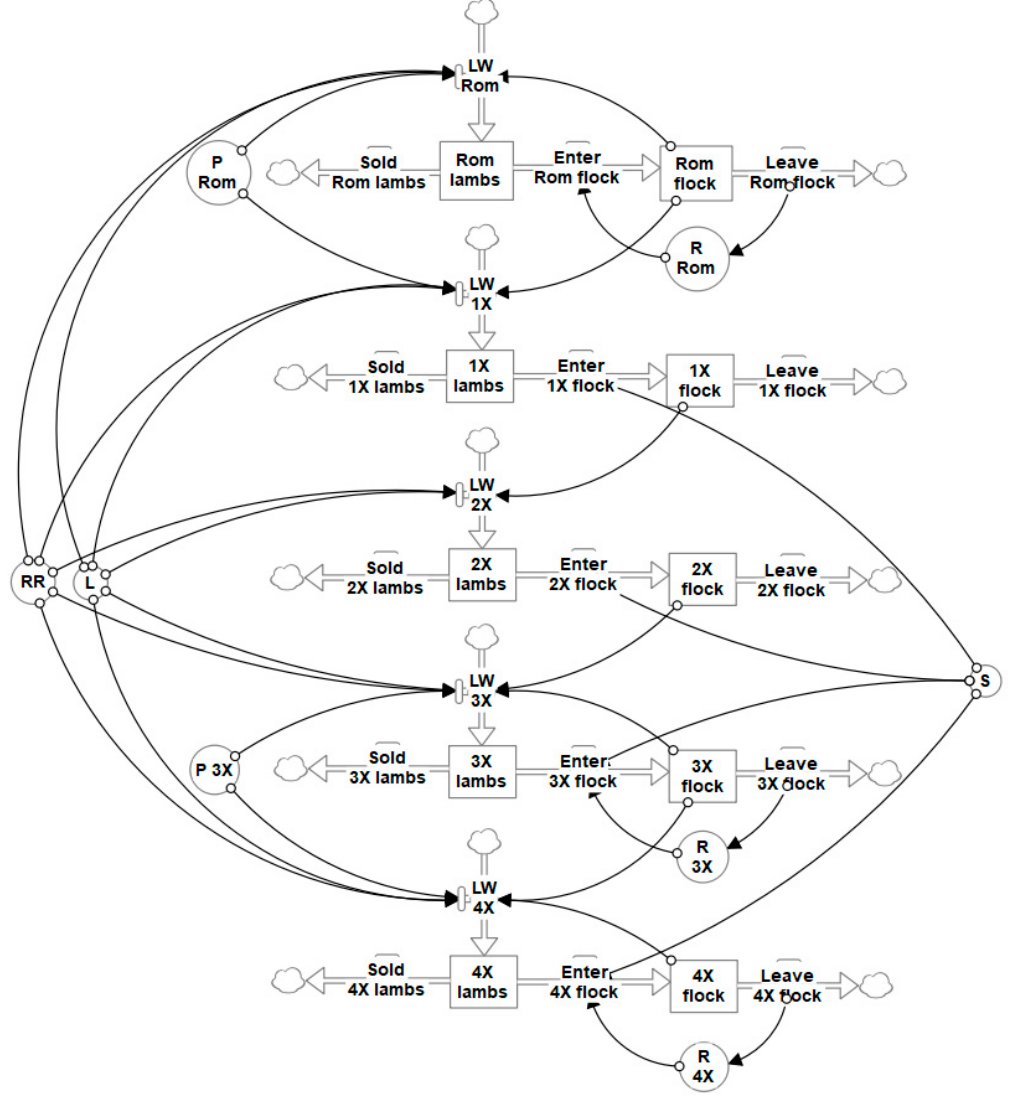
Figure 1. Simplified diagram of the flock dynamics for a flock grading up transition from purebred Romney (Rom) to either a third (3X or 7 / 8 W 1 / 8 R) or fourth (4X or straightbred) generation crossbred. Lambs weaned (LW) for each cross are a product of P (proportion of ewes bred with a Wiltshire sire), L (lambs weaned per ewe presented for breeding), flock (number of ewes in the flock), and RRi